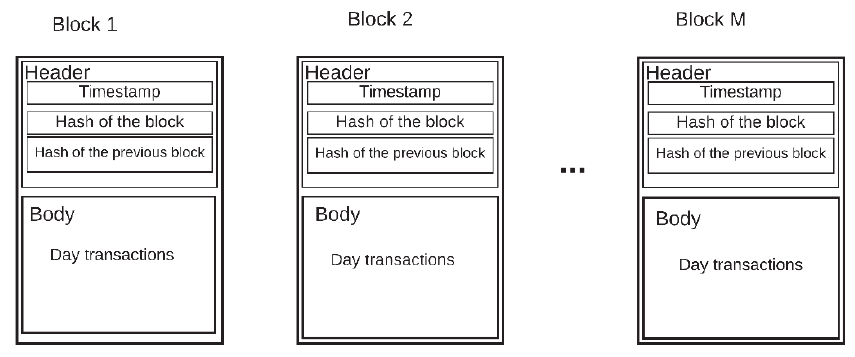
Figure 1. Blockchain general structure.